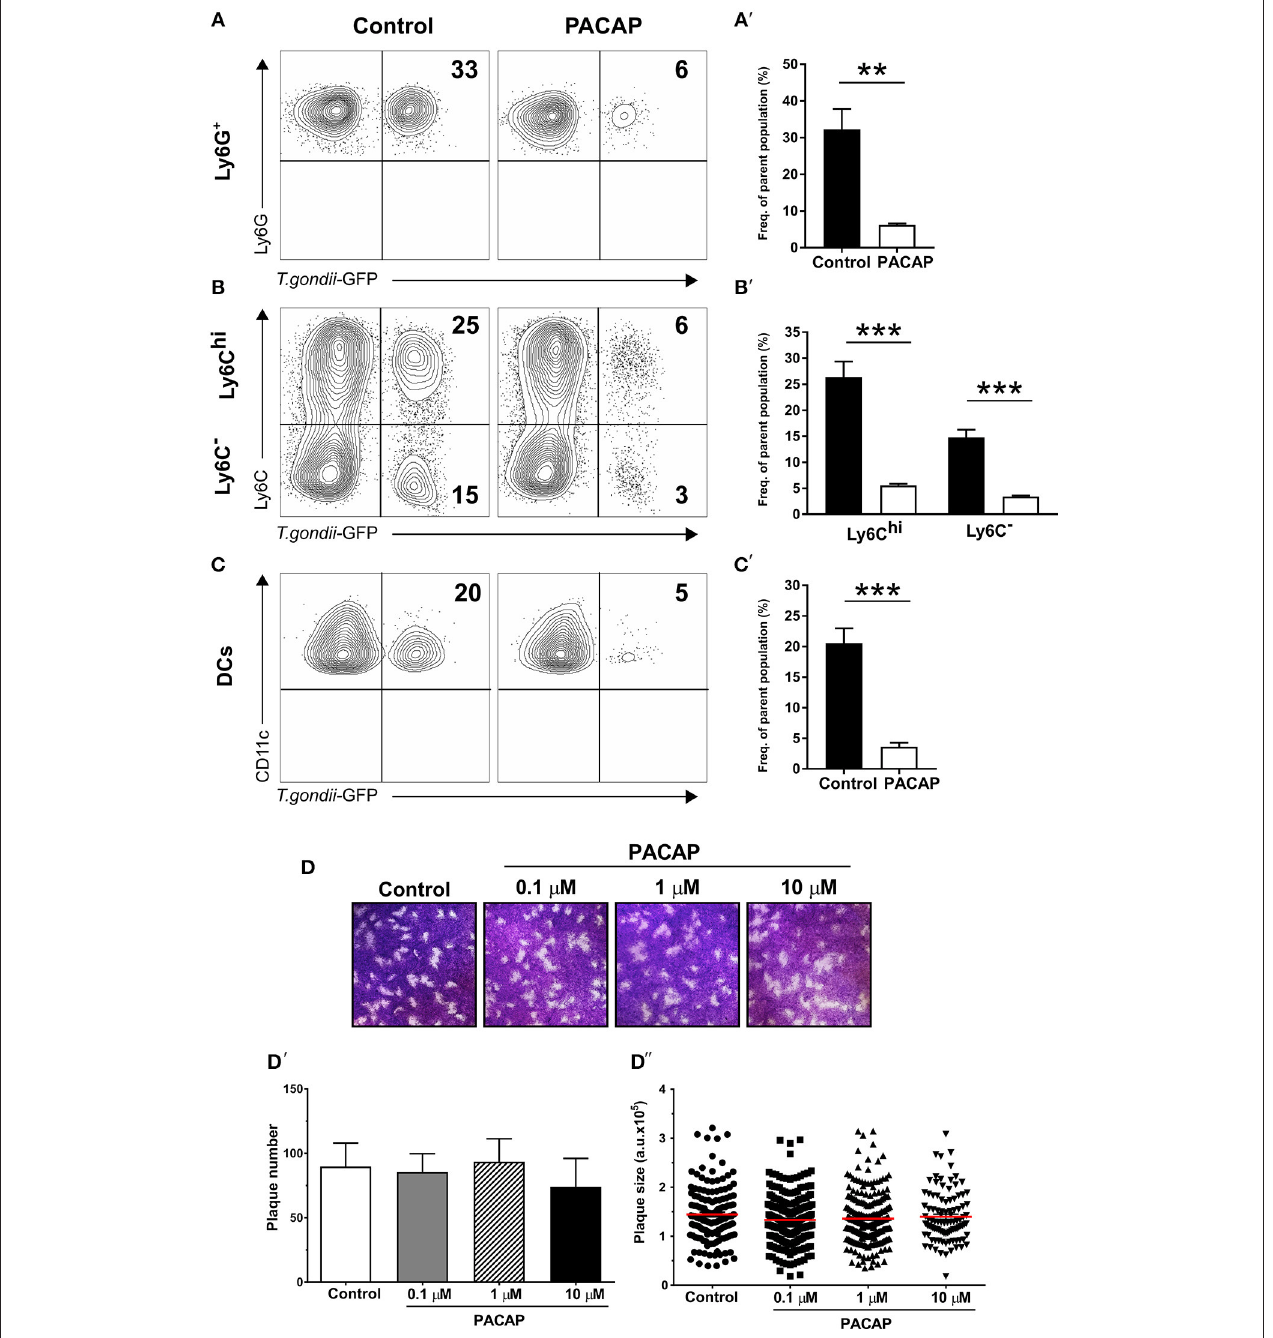
FIGURE 2 | Anti-parasitic effect of myeloid peritoneal immune cells upon PACAP-treatment. Peritoneal cells of acutely-infected mice were isolated and analyzed by flow cytometry. A GFP-fluorescent T. gondii reporter was used to track the presence of the parasite in myeloid peritoneal subsets selected as described above. (A–C) Contour plots show the presence of GFP + cells for each cell subset in control (left column) and PACAP-treated (right column) group. Numbers represent the mean percentage of parent population for each group from a representative experiment ( n = 4). ( A ′ –C ′ ) Bar charts compare the frequency of GFP + cells. Control (black bars) and PACAP-treated (white bars). (D–D ′′ ) Representative images show in vitro replication of T. gondii by plaque assays in the presence of PACAP. Plaques from three independent experiments were scored for size and numbers using ImageJ. (D) Images of the formed plaques initially infected with 200 tachyzoites/well; numbers indicate different PACAP concentration. (D ′ ) Scored number of plaques under different concentrations of PACAP. (D ′′ ) Scored plaque sizes shown as arbitrary units (a.u.) in the presence of different PACAP concentrations. Data are expressed as mean ± SEM, ** p < 0.01, *** p < 0.001 (two-tailed unpaired t -test).